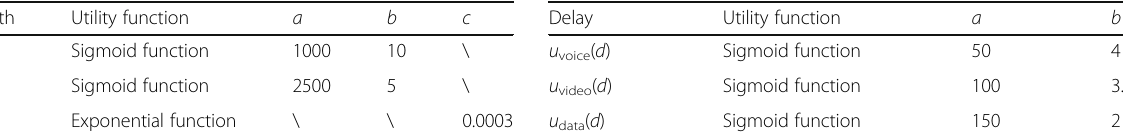
Table 1 Utility function for bandwidth and parameter settings